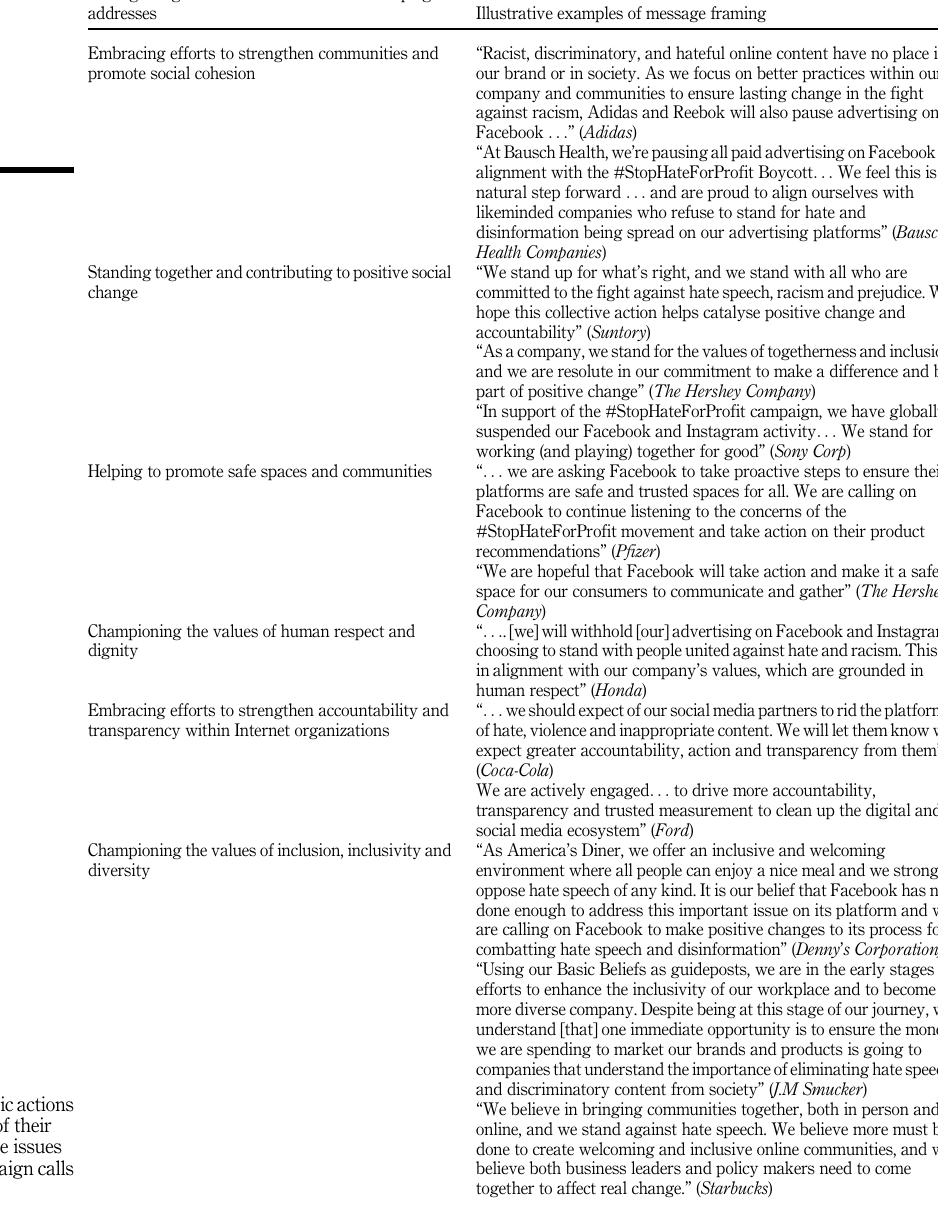
Table 2. Firms ’ strategicactions and framing of their position on the